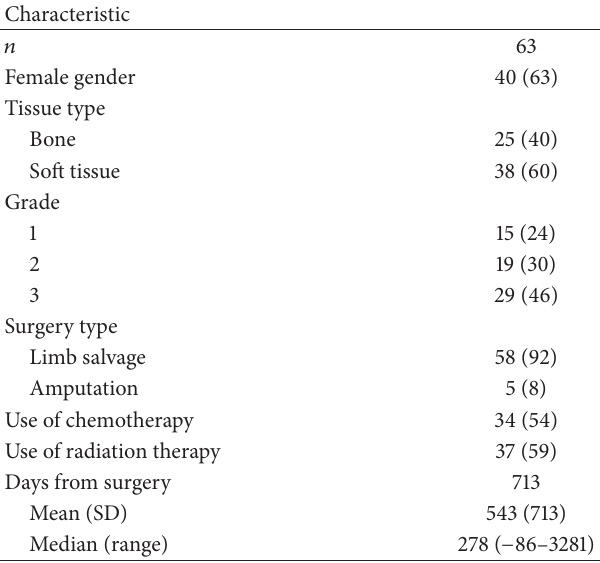
Table 1: Characteristics of study